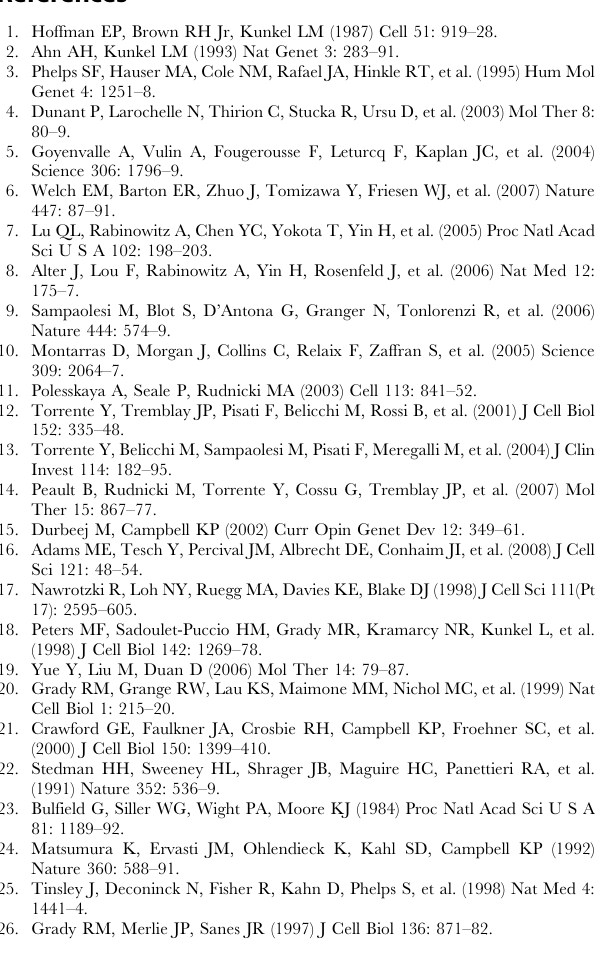
Table S4 Comparison of gene expression profiles between 4